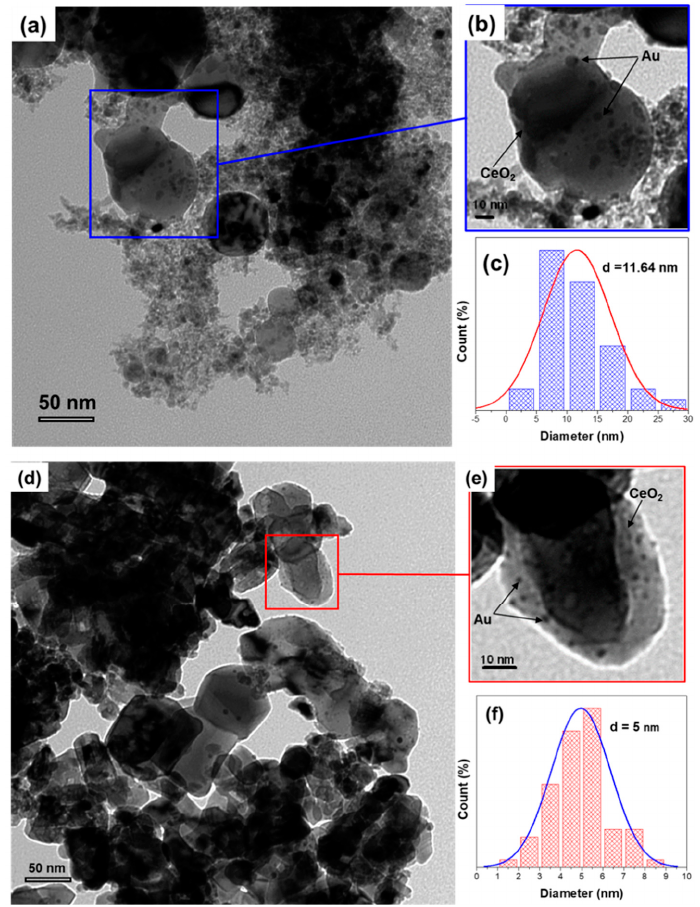
Figure 9. TEM micrographs and particle size distribution of Au / CeO 2 prepared by the physical method (LVCC) ( a – c ) and the chemical method (DP) ( d – f )., after the heat treatment in the CO / O 2 mixture (second light-o ff ), the light-o ff temperature was shifted for both catalysts—from 50 ◦ C to 27 ◦ C for the LVCC catalyst and from 0.1 ◦ C to 28 ◦ C for the DP catalyst—as shown in Figure 8. Table 3 shows the activities of Au / CeO 2 prepared by physical and chemical methods after heat treatment in the CO / O 2 mixture (second light-o ff